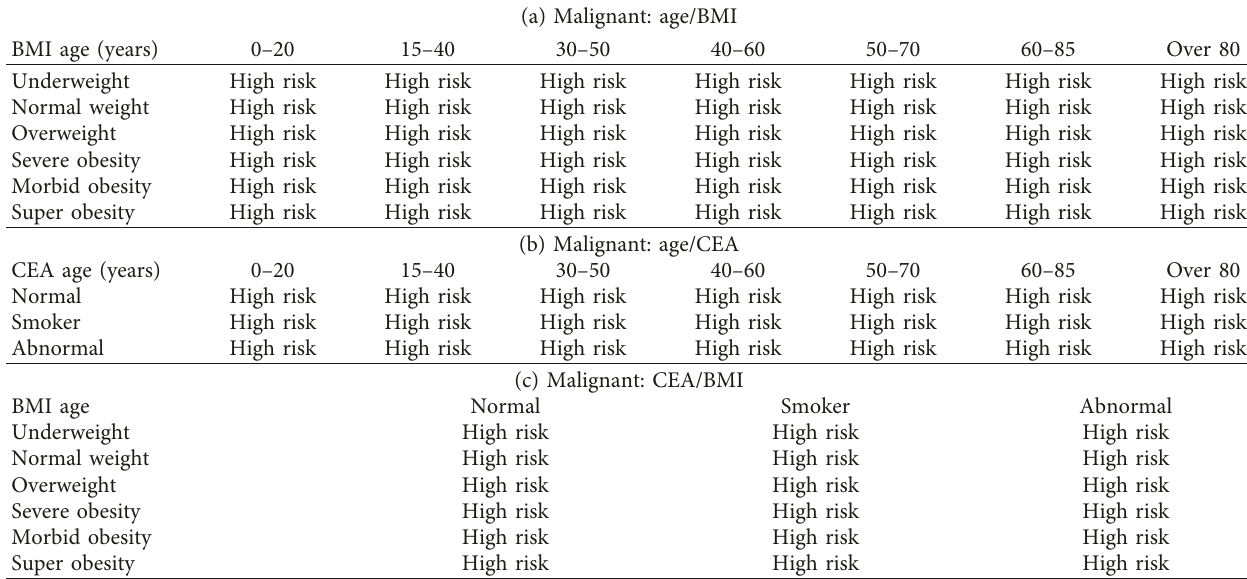
Table 5: Risk of tumor. (a) Malignant: age/BMI; (b) age/CEA; (c)